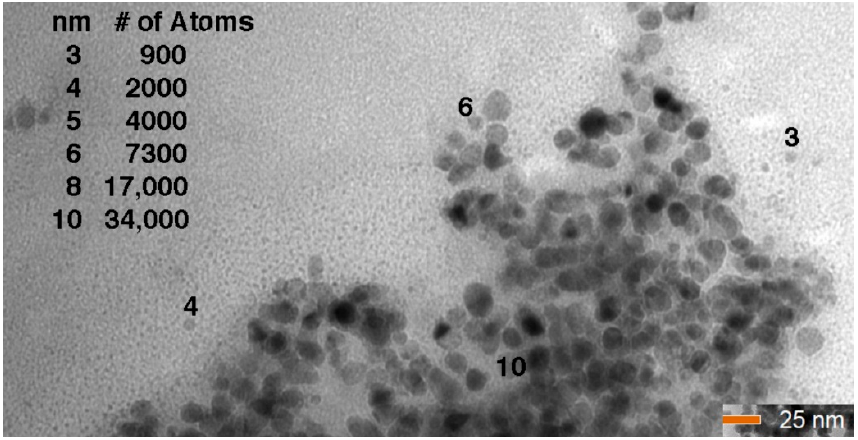
Figure 10. Transmission electron microscopy (TEM) image of nickel nanopartile manufactured by the QuatumSphere Inc. [58].